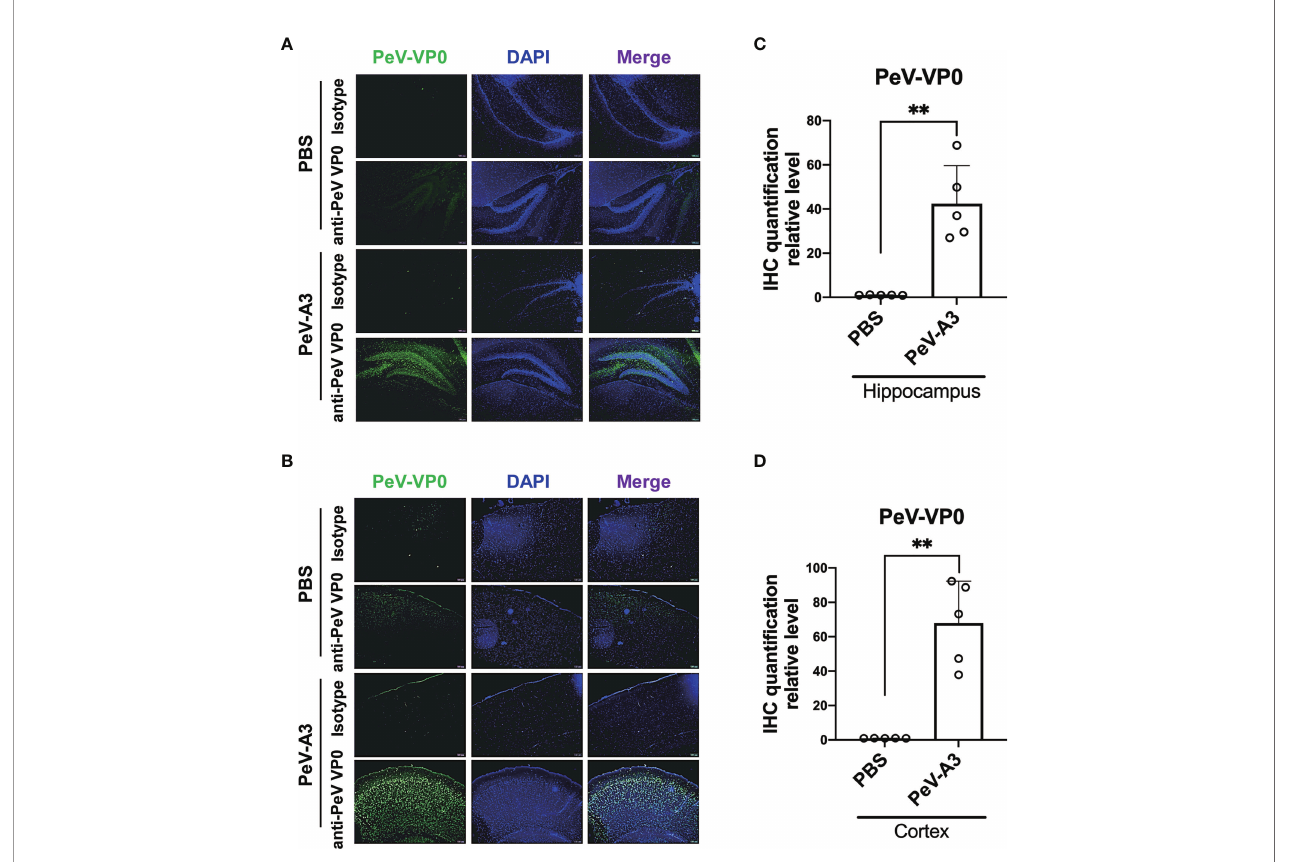
FIGURE 7 | Fluorescence immunohistochemistry assay (IHC) of PeV-A3 infection in neonatal mouse brain. (A, B) Immunohistochemically staining for PeV-VP0 in the hippocampus and cortex section (PBS control, N = 5; PeV-A3, N = 5). Scale bar = 100 µm. (C, D) Quanti fi ed PeV VP0 protein level of the IHC assay of each mouse brain tissue are shown as scattered plots. Data are mean ± SD. Student ’ s t-test, ** p < 0.01 compared with PBS. PeV-A3, parechovirus type 3; PBS, phosphate- buffered